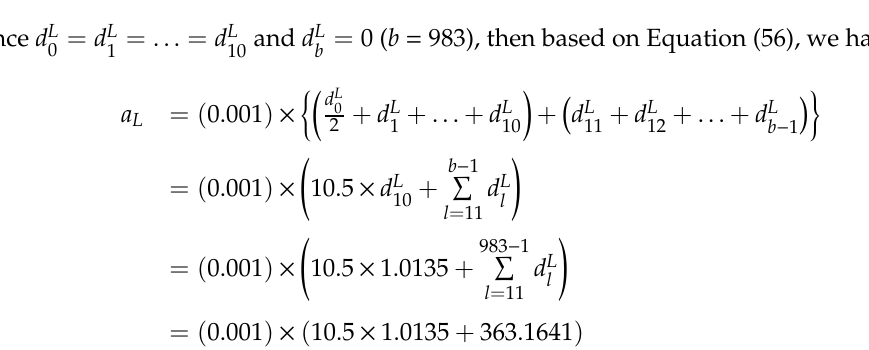
= 4.060. C − = 4.060. 0 0